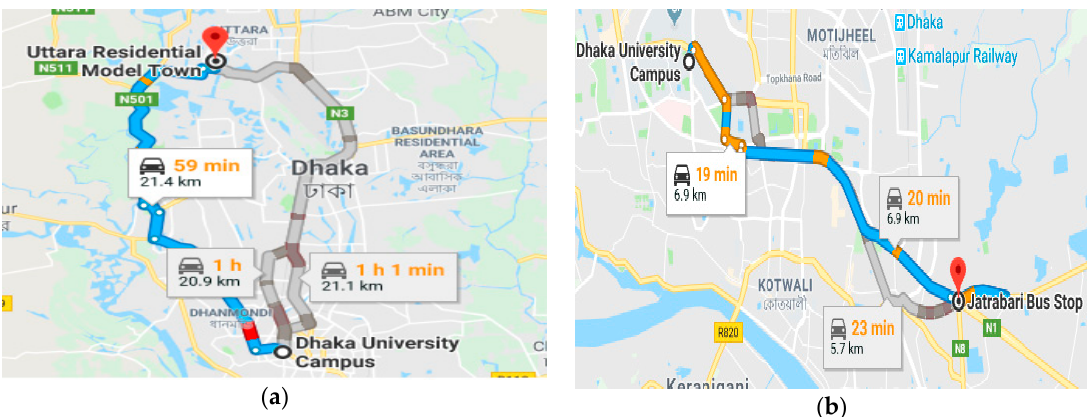
Figure 3. The typical map used for the calculation of the distance between ( a ) Dhaka University to Uttara and ( b ) Dhaka University to Jatra Bari.